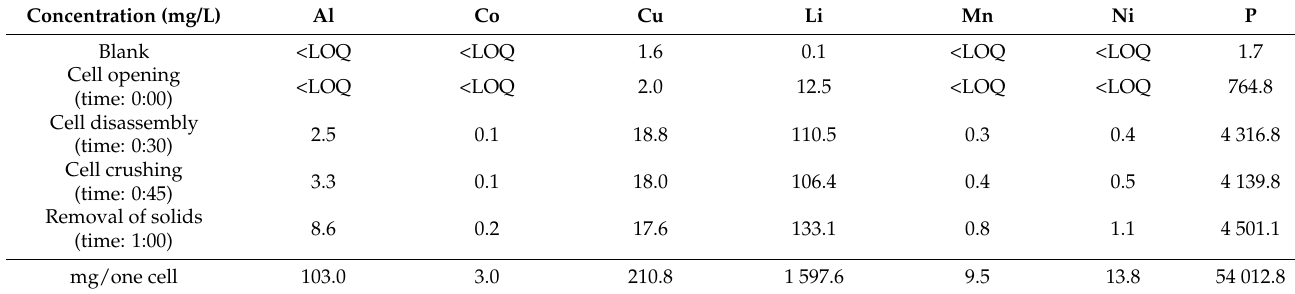
Table 5. Electrolyte and electrode dissolution in aqueous solution.